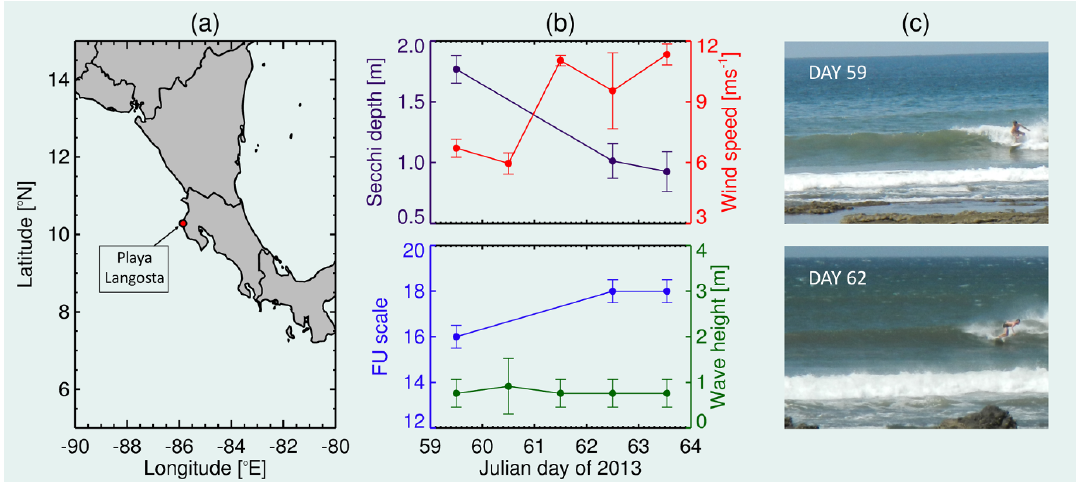
Figure 8. Deployment of the mini-Secchi disk by a surfer. ( a ) Location of Playa Langosta in Costa Rica. ( b ) Data collected using the mini-Secchi disk (Secchi-depth and FU colour scale) between 28th February and 4th March 2013 at Playa Langosta. Wind speed data from nearby weather station (Sede de Guanacaste, Liberia) and wave height data at Langosta (using wave model forced with observations) are also shown. Uncertainties (error bars) for the Secchi depth and wind speed are based on standard deviations of measurements during the surfing session (5–7 for the Secchi depth), or around local noon for wind speed for the days of no deployment. Uncertainties (error bars) in wave height represent the range in wave heights from the wave model data. Uncertainties (error bars) in FU colour scale were set to half an FU number based on reproducibility results in Wernand and van der Woerd [5]. ( c ) Photos taken of the surfer at Playa Langosta in Costa Rica on the 28th February (Day 59) and 3th March (Day